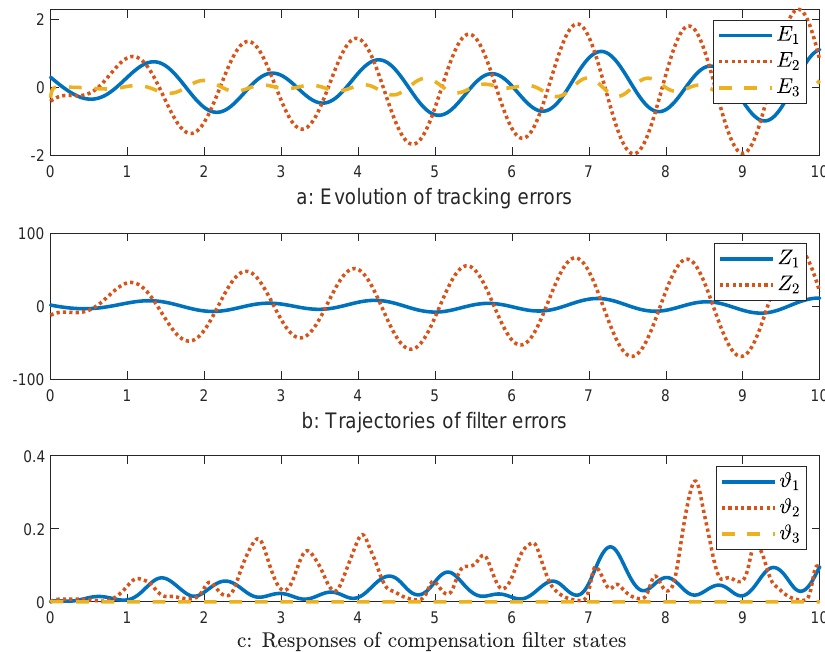
Figure 11. Curves of error signals and compensation filter